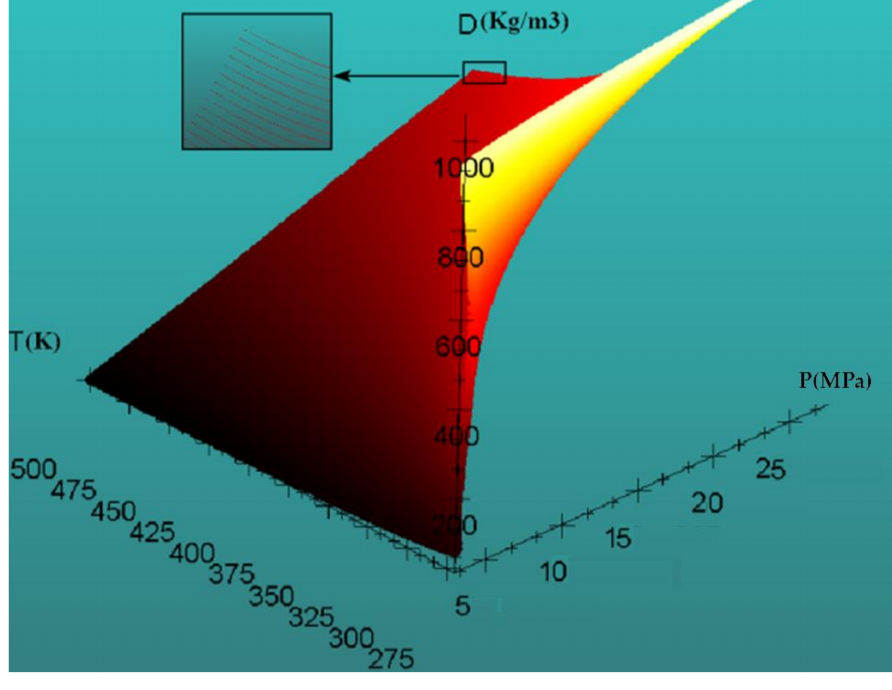
Figure 7. Density table for simulation.